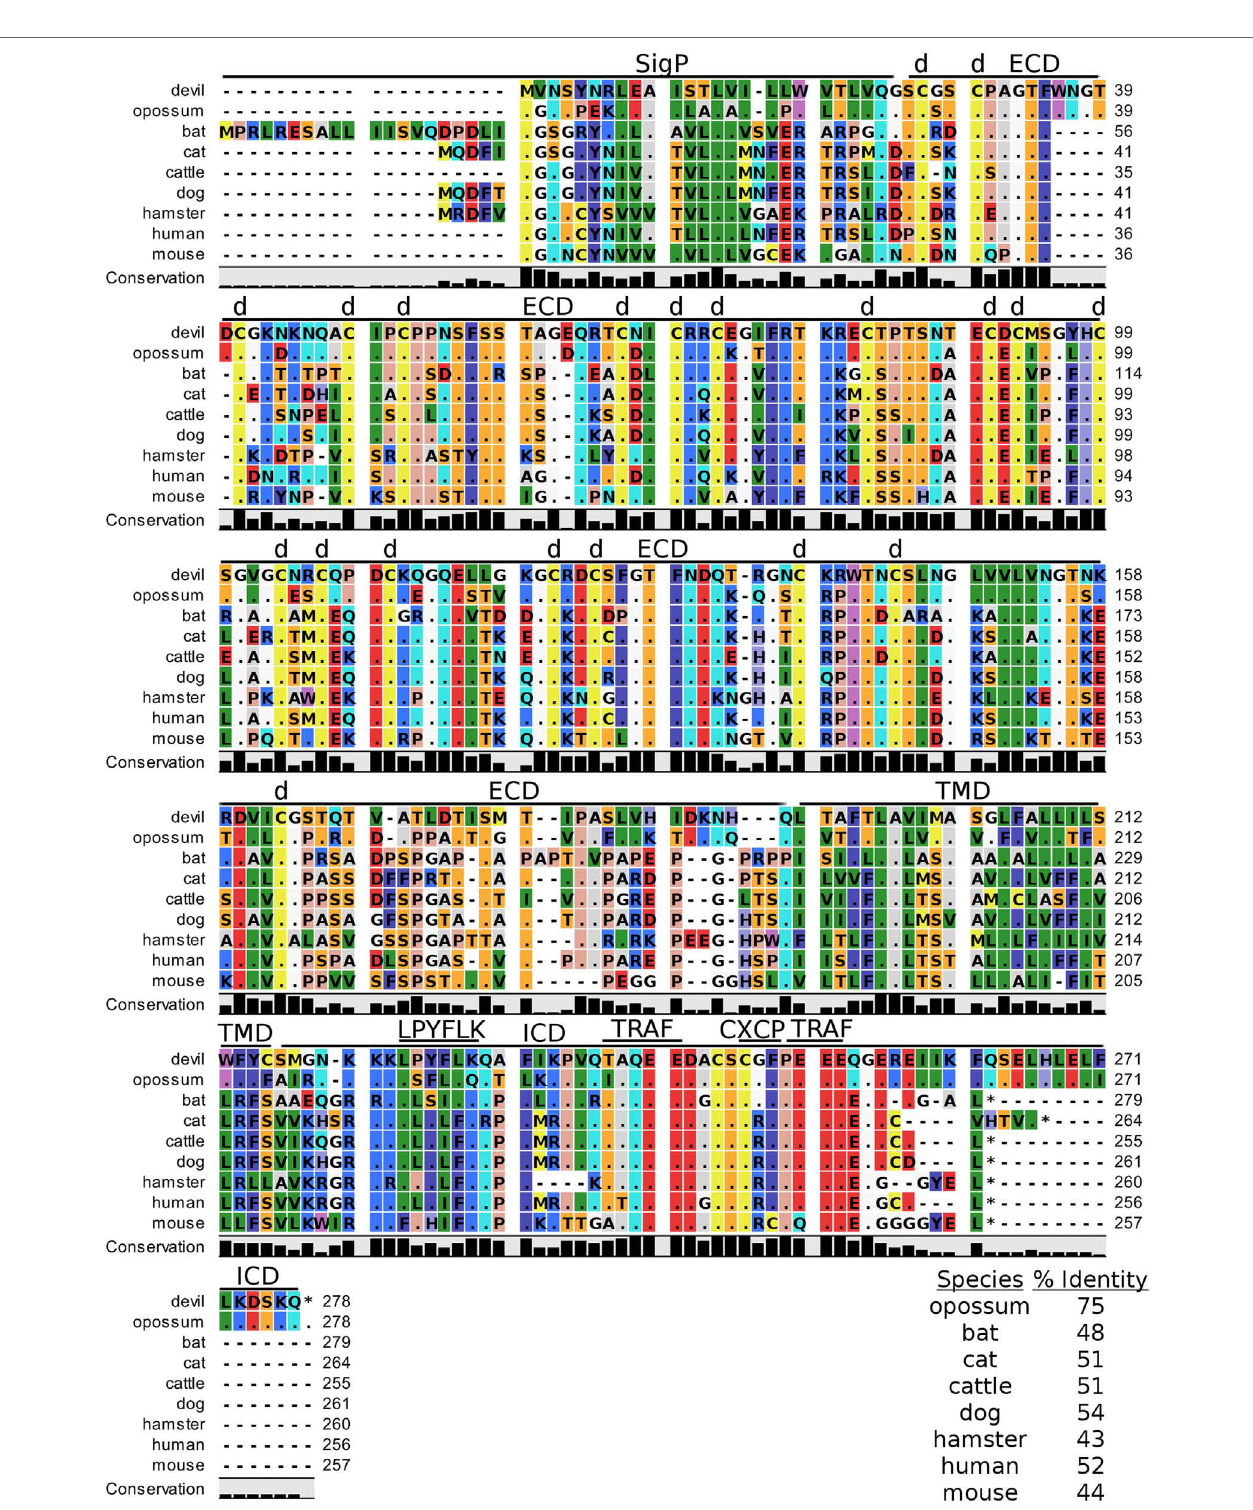
FigUre 7 | alignment of 4-1BB reference genes for nine species . The predicted signal peptides (SigP), extracellular domain (ECD), transmembrane domain (TMD), and intracellular domain (ICD) are demarcated with bars. “d” above the alignment represents predicted disulfide bonds. Two potential TRAF1/2-binding sites are demarcated by “TRAF.” “CXCP” marks a motif associated with optimal T cell response in mice, and “LPYFLK” denotes a potential inhibitory domain in devils. The black bar graphs below the alignment represent the conservation of amino acids across all nine species. The percent amino acid sequence identity between devils and other species is shown in the bottom right corner of the